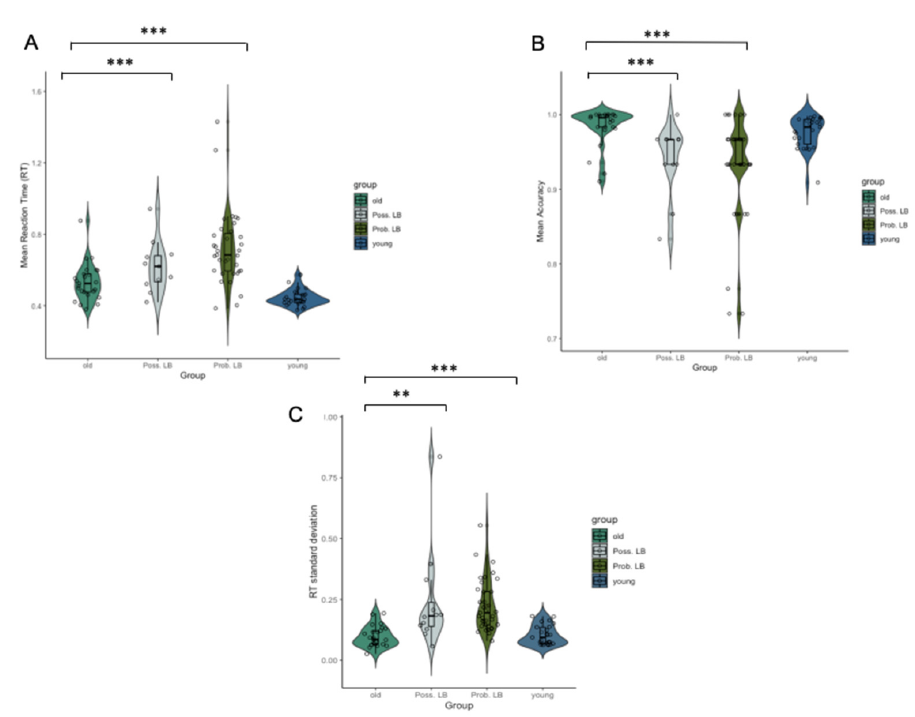
Figure 2. ( A ) Diagnostic group differences in mean reaction time (RT) ( B ) Group differences in mean